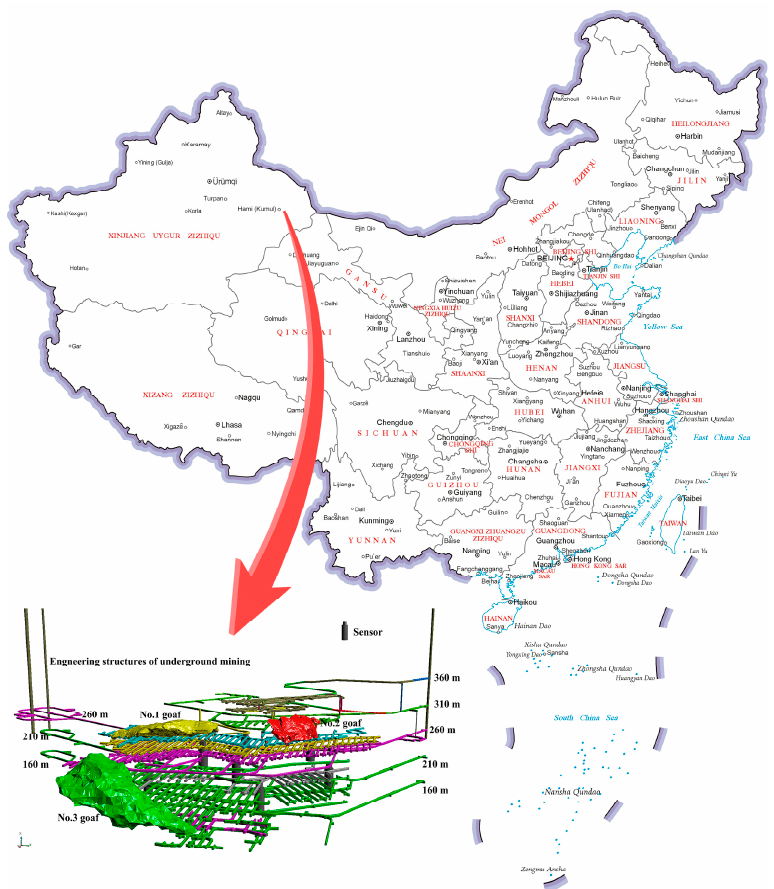
Figure 1. A mining-induced microseismic monitoring system was installed to monitor the safety of goaves in the Huangtupo Copper and Zinc